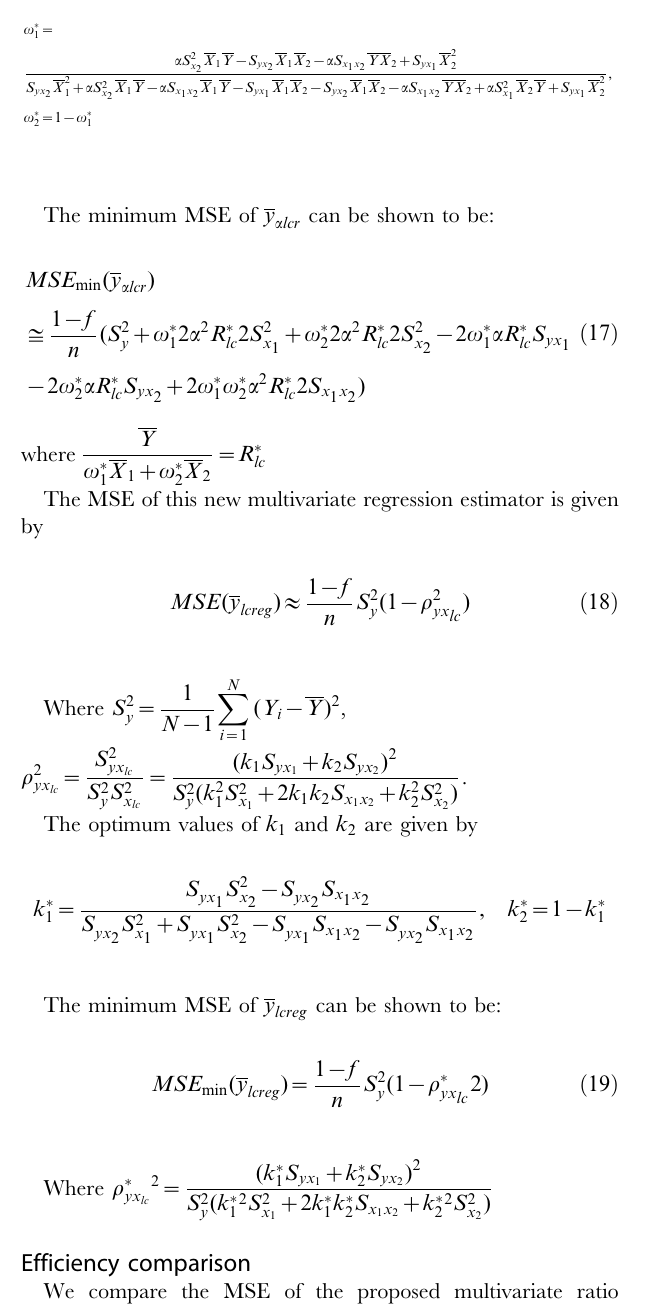
Table 1. Data Statistics.